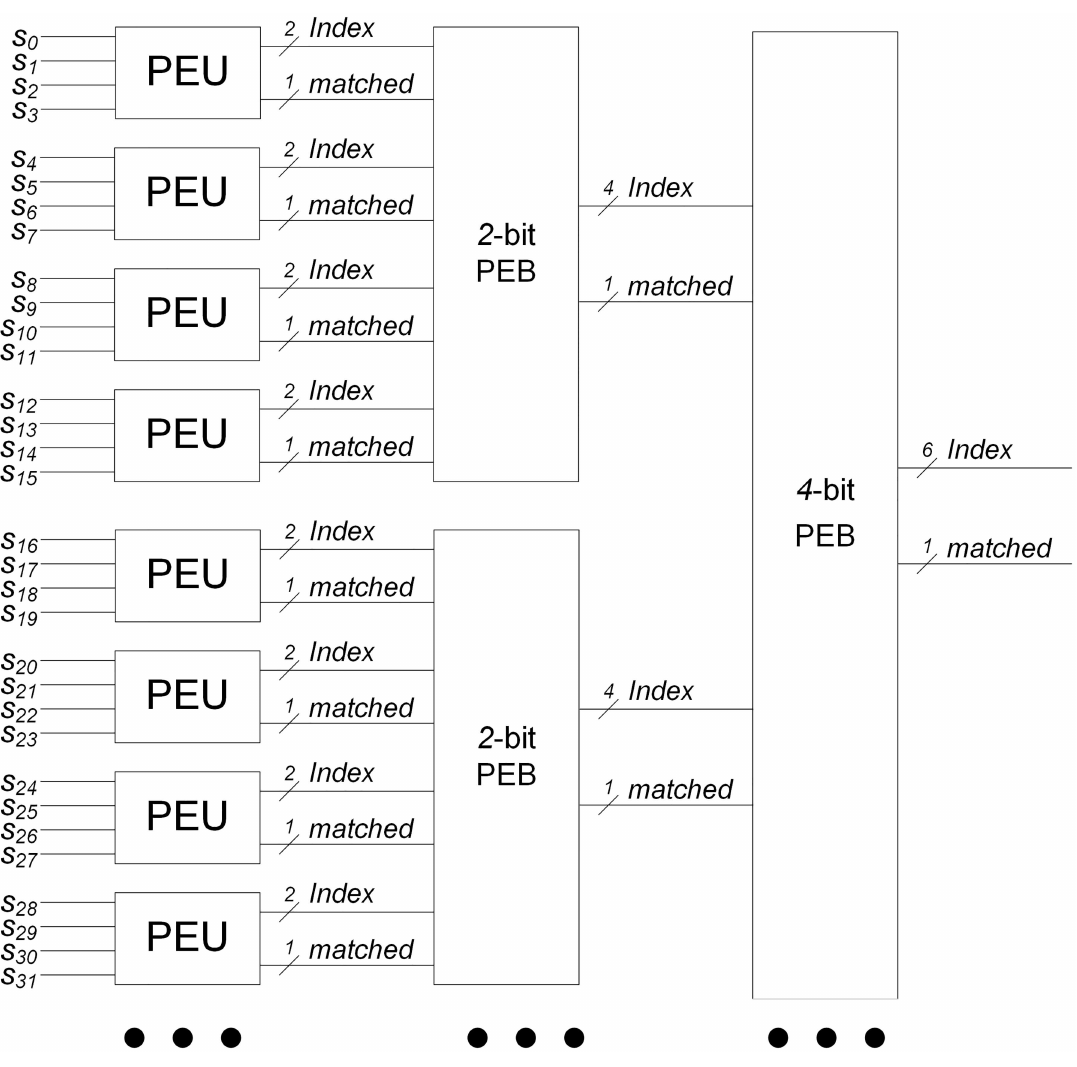
Fig 7. An example of pipelined priority